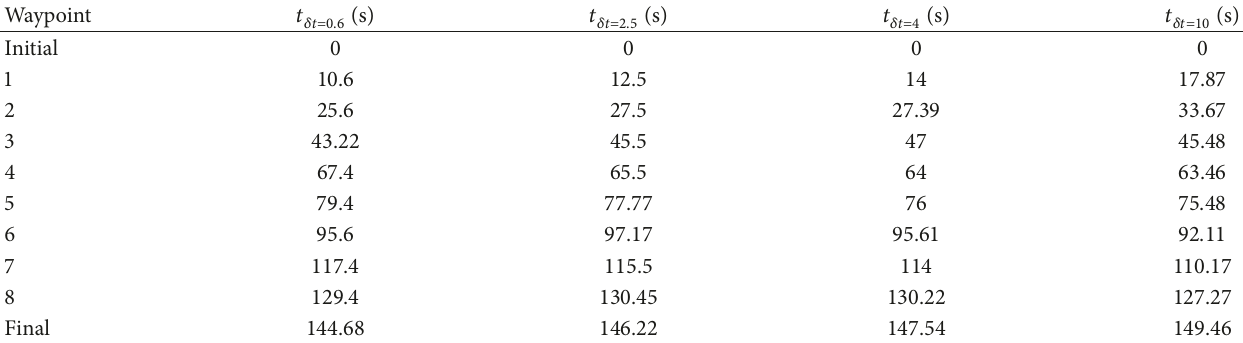
Table 10: Waypoints configuration with their optimal overfly-times schedule.